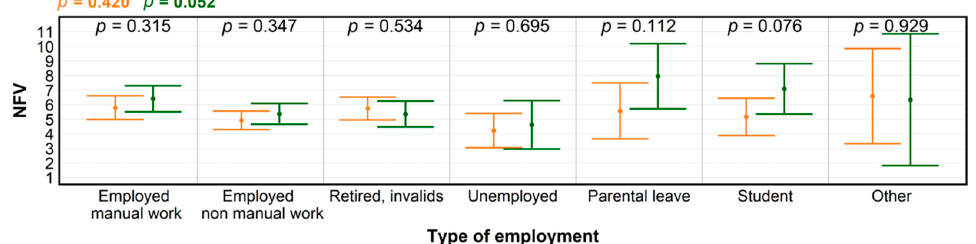
Figure 5. Levels of significance for differences in numbers of forest visits (NFV) according to type of employment, before (orange) and during the COVID-19 pandemic (green), produced by ANOVA; and for within-group NFV differences (black), determined by t -test.